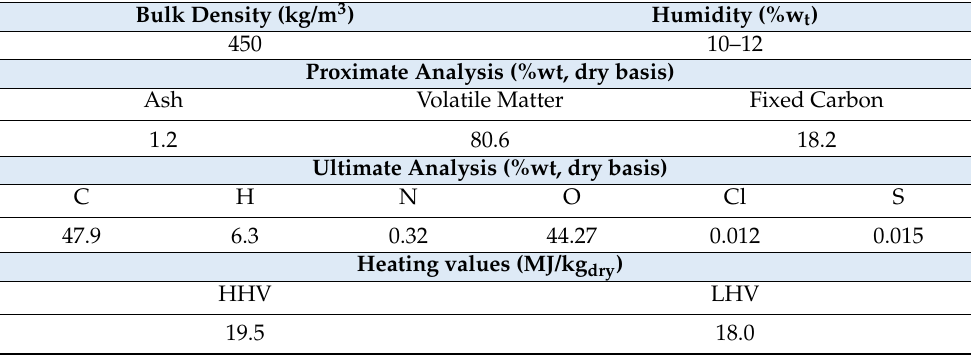
Table 1. Physical and chemical characteristics of almond shells.